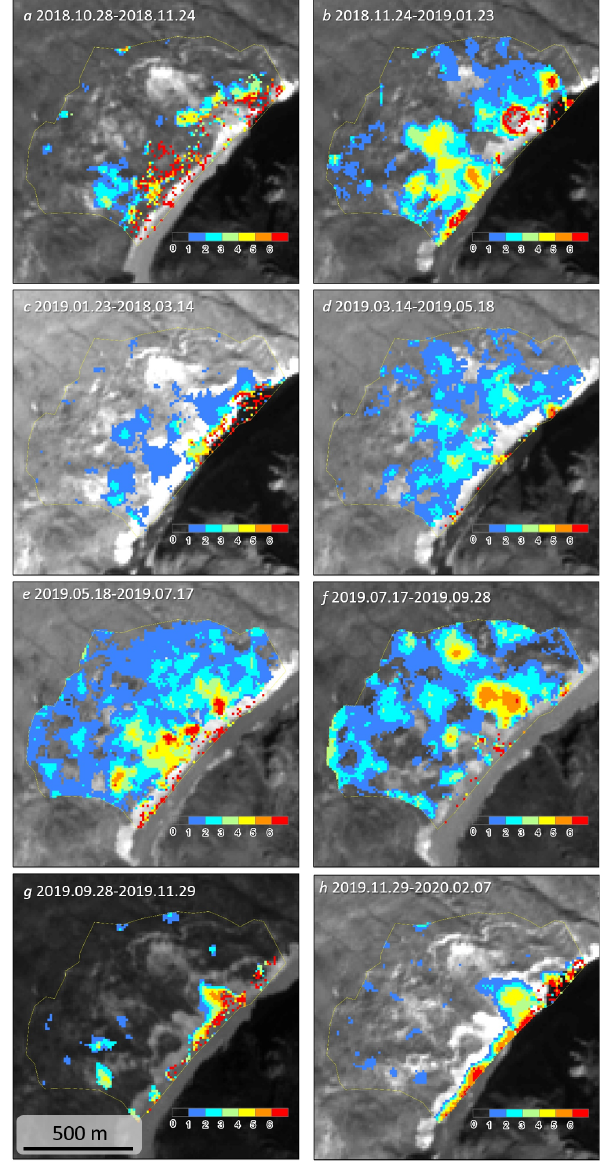
Figure 5. Slope displacements in different periods after the Baige floods (background images are Sentinel-2 data produced by ESA’s Sentinel-2 satellites and downloaded via the